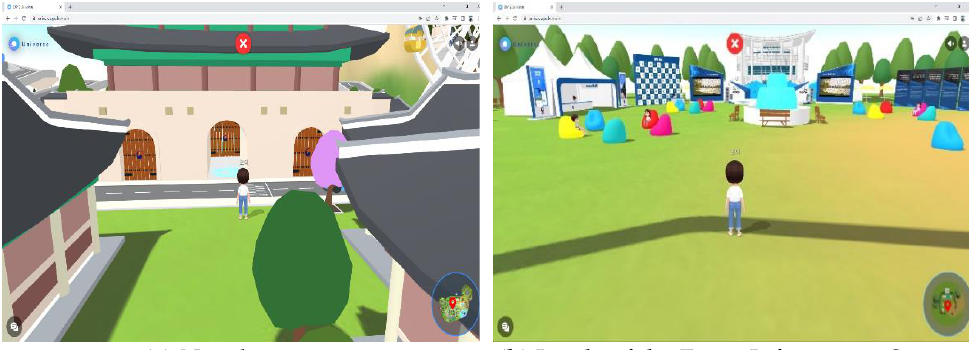
Figure 13. Event Information.